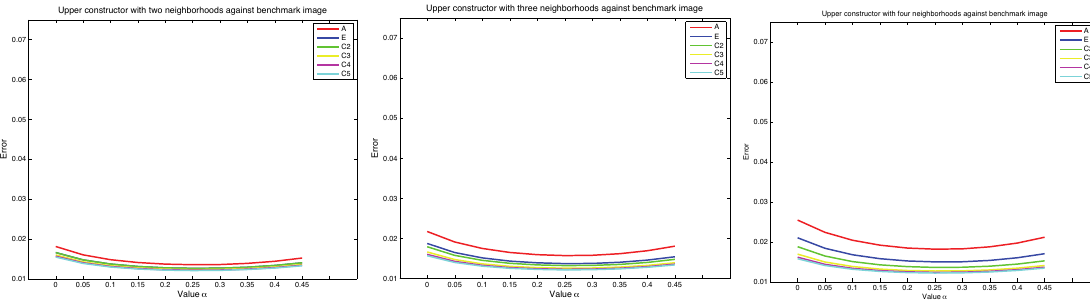
Figure 5: Performance of the lower constructor when 2 (left), 3 (middle) or 4 (right) neighborhoods are consid- ered